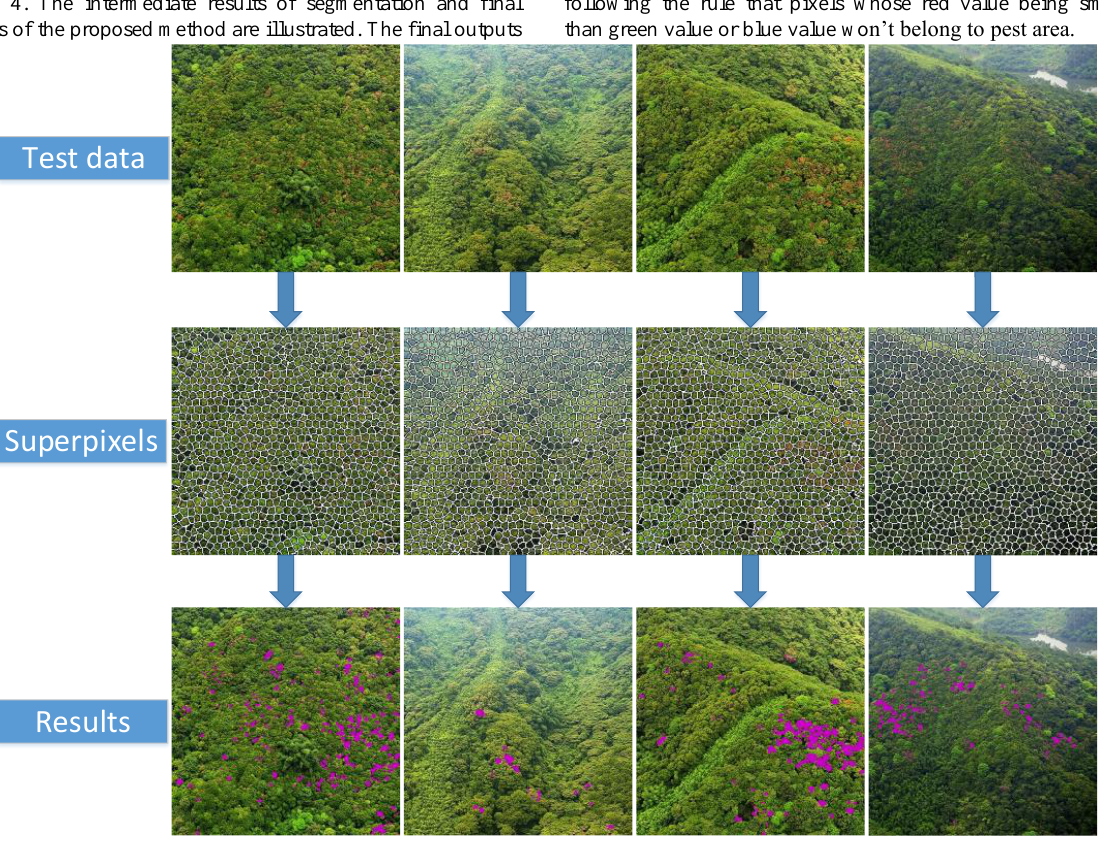
Table 2 Algorithmic steps of Random Forest.